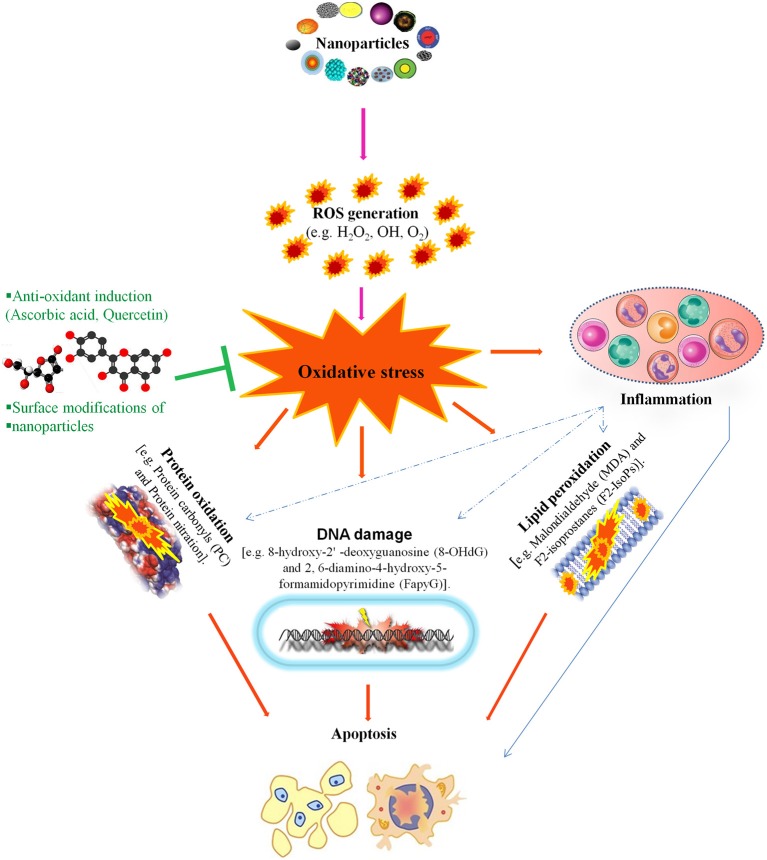
This figure illustrates that nanotoxicity produced by overproduction of free radicals which induced oxidative stress. Oxidative stress causes lipid peroxidation, protein oxidation and DNA damages, these all together potentiate inflammatory response by implying variety of inflammatory pathways. On the other hand, antioxidant defense encounter the production of oxidative stress and ameliorate reproductive nanotoxicity of animal models. Modified from Khanna et al. (2015).